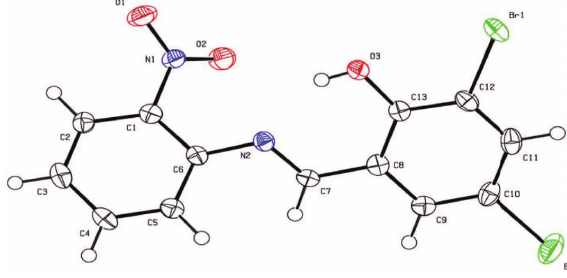
Table 1: Data collection and handling.